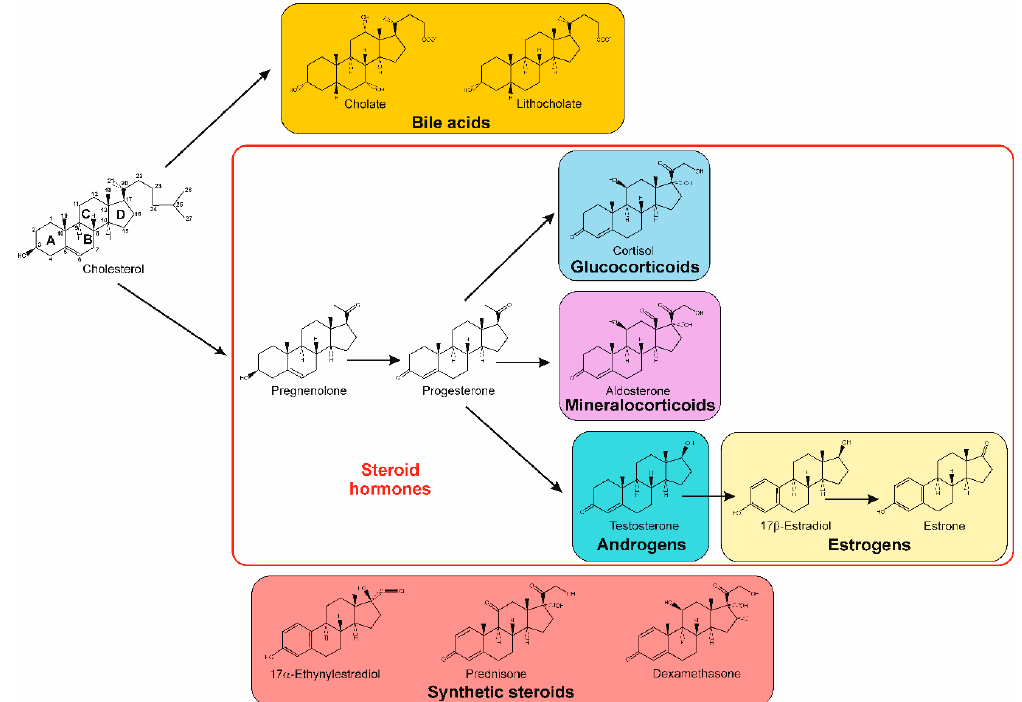
Figure 1. Chemical structure of cholesterol and some of its mammalian derivatives, and selected synthetic steroids.